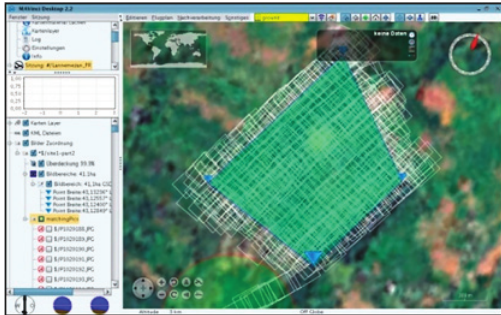
Fig. 10. Imported 3D model after post processing from MAVinci Desktop flight planning software (Images … 2011)